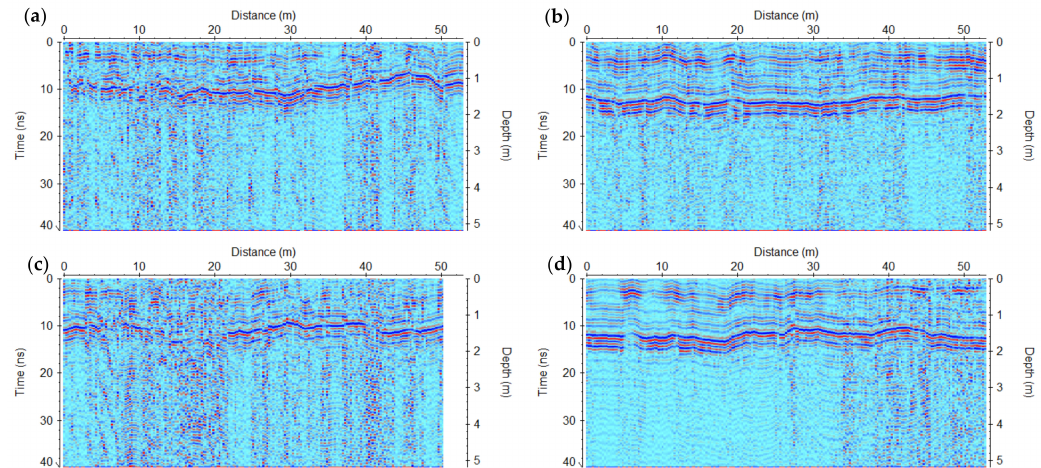
Figure 13. Four parallel sections of the Gressoney test sites after subtracting the flight altitude (letters ( a – d ) correspond to the 4 GPR sections indicated in the bottom left of Figure 5).